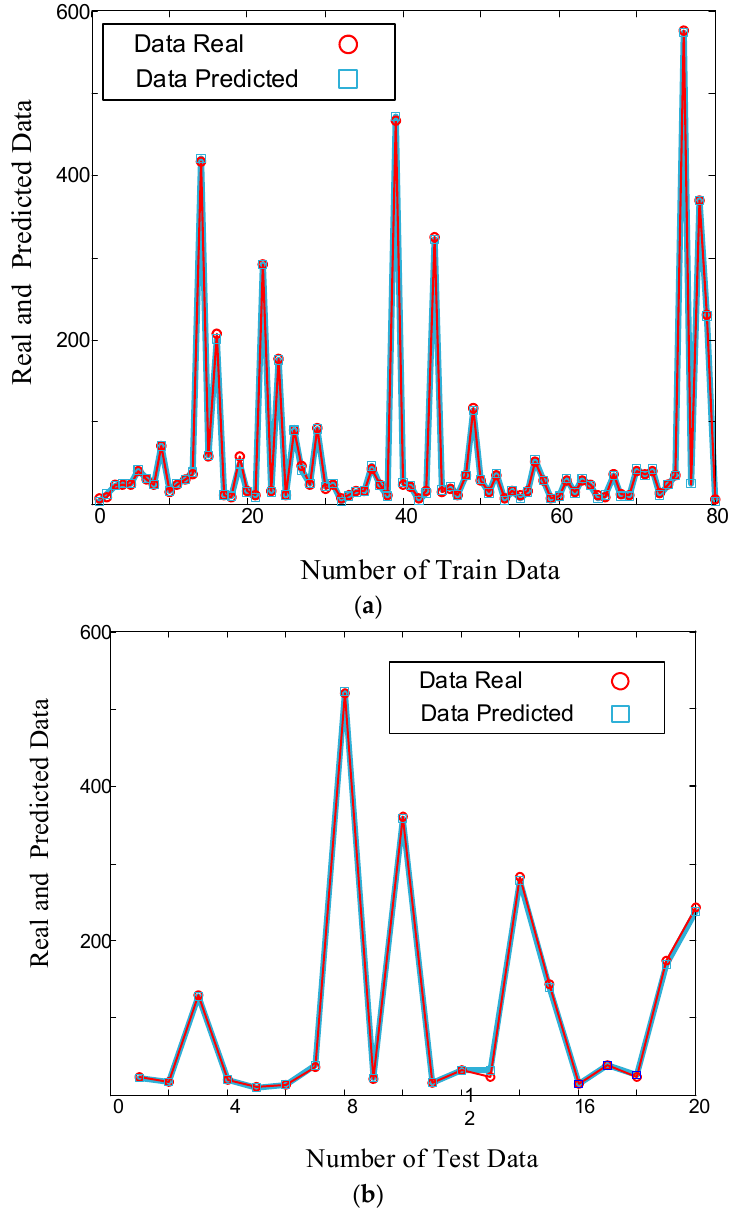
Figure 10. Real and predicted circuit output resistor values for ( a ) train and ( b ) test data of the final proposed ANN–PSO network versus number of samples.